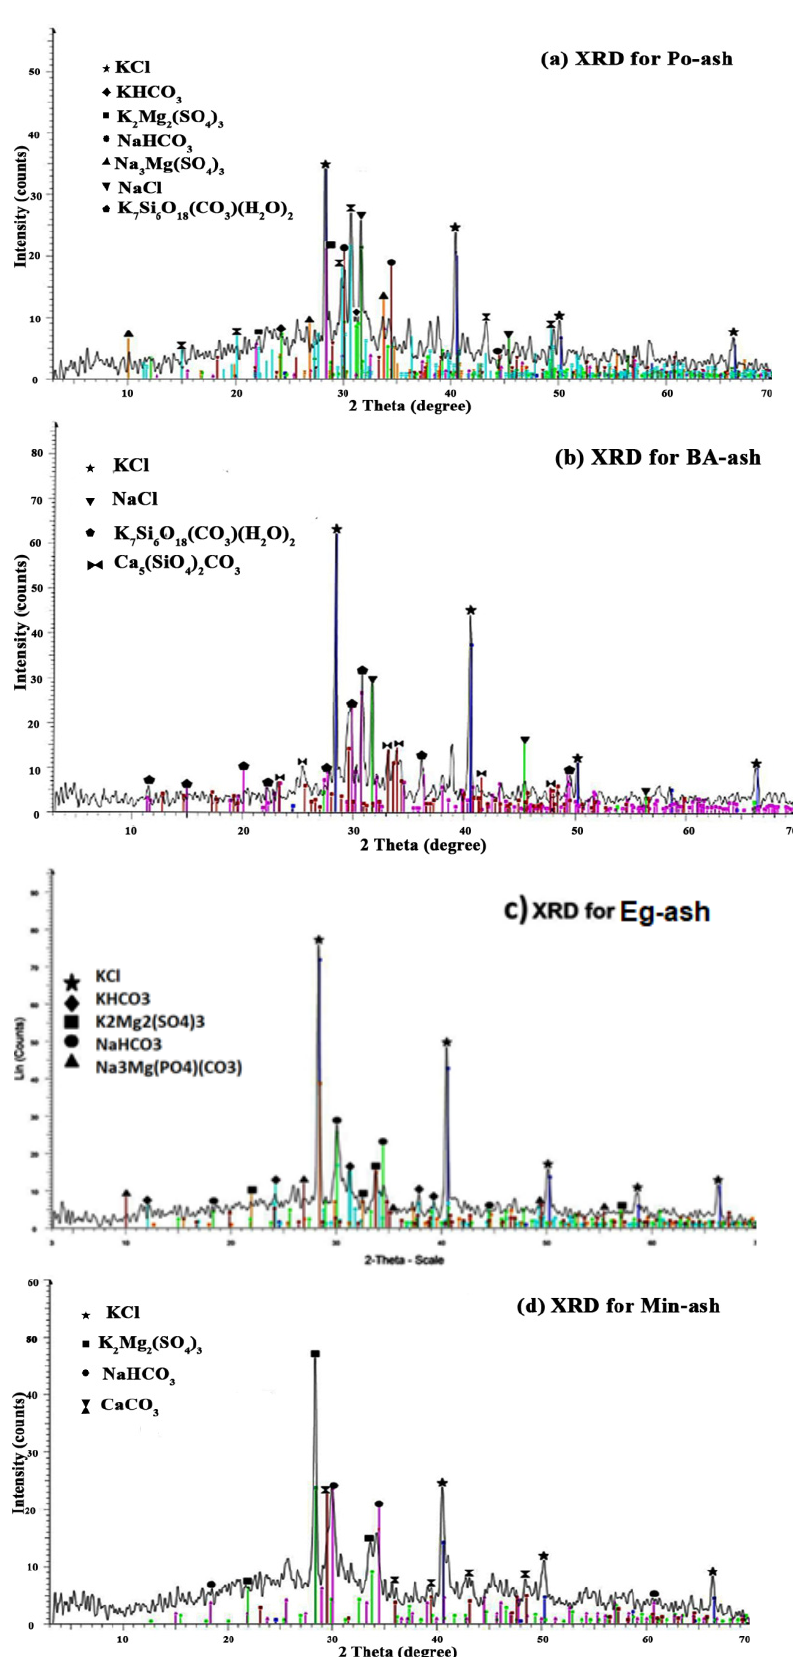
Figure 2. The XRD patterns for the characteristics of the agro-ash compositions: ( a ) Po-ash, potato peel ash; ( b ) BA-ash, banana peel ash; ( c ) Eg-ash, eggplant peel ash; ( d ) Min-ash, mint stem ash materials. Table 1. XRD analysis of the constitutions of the tested agro-ashes, (Po-ash is Potato peel Ash, BA-ash is Banana peel Ash, Eg-Ash is Eggplant ash, and Min-Ash is Mint stem ash). Minerals Phase